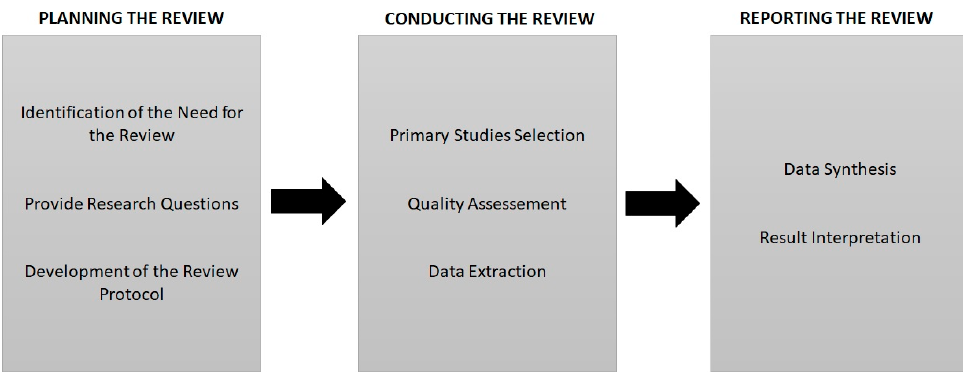
Figure 1. The systematic review steps (guidelines)